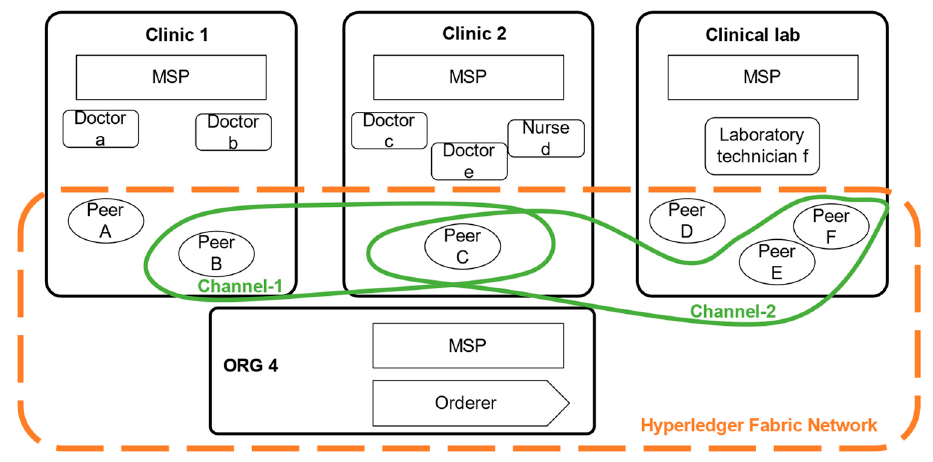
Figure 2. Organizations, clients, and peers in Fabric